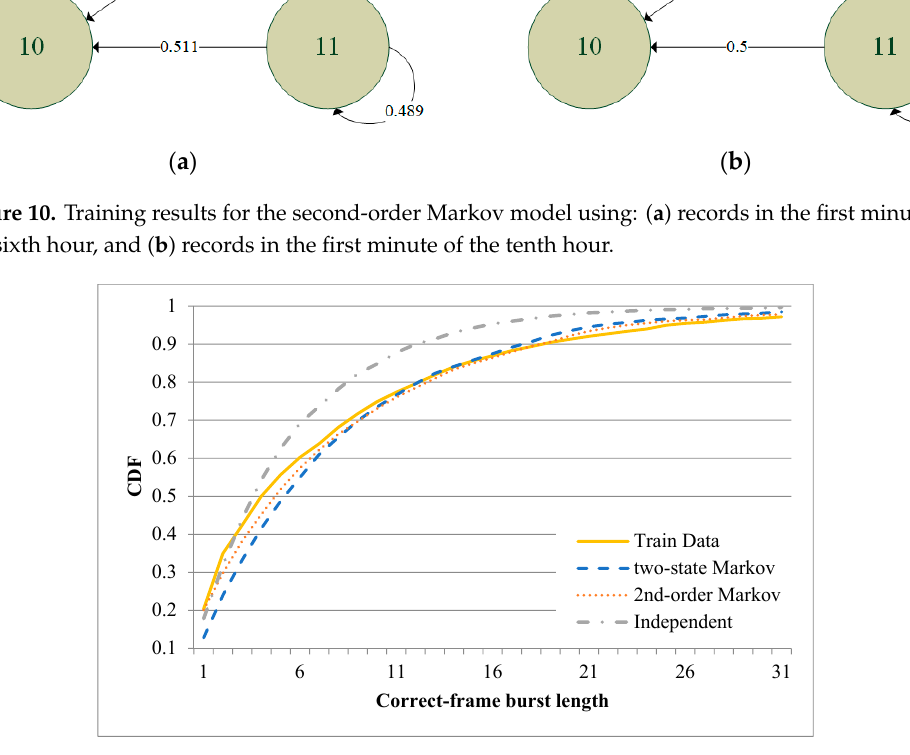
Figure 11. Cumulative Distribution Functions (CDFs) of correct-frame burst length derived using different error models based on recorded trace in the first minute of the sixth hour.